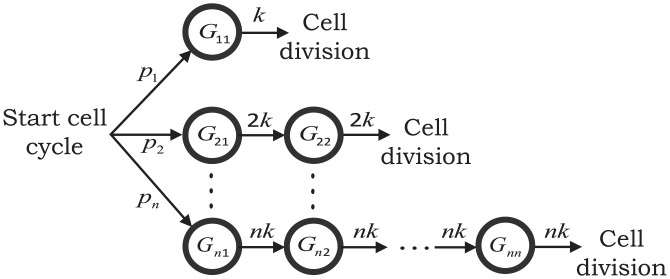
A continuous-time Markov chain model for the cell-cycle time.Left: The cell-cycle time is assumed to follow a mixture of Erlang distributions. At the start of cell cycle, a state Gi1, i = {1, …, n} is chosen with probability pi. The cell cycle transitions through states Gij, j = {1, …, i} residing for an exponentially distributed time with mean 1/ik in each state. Cell division occurs after exit from Gii and the above process is repeated.